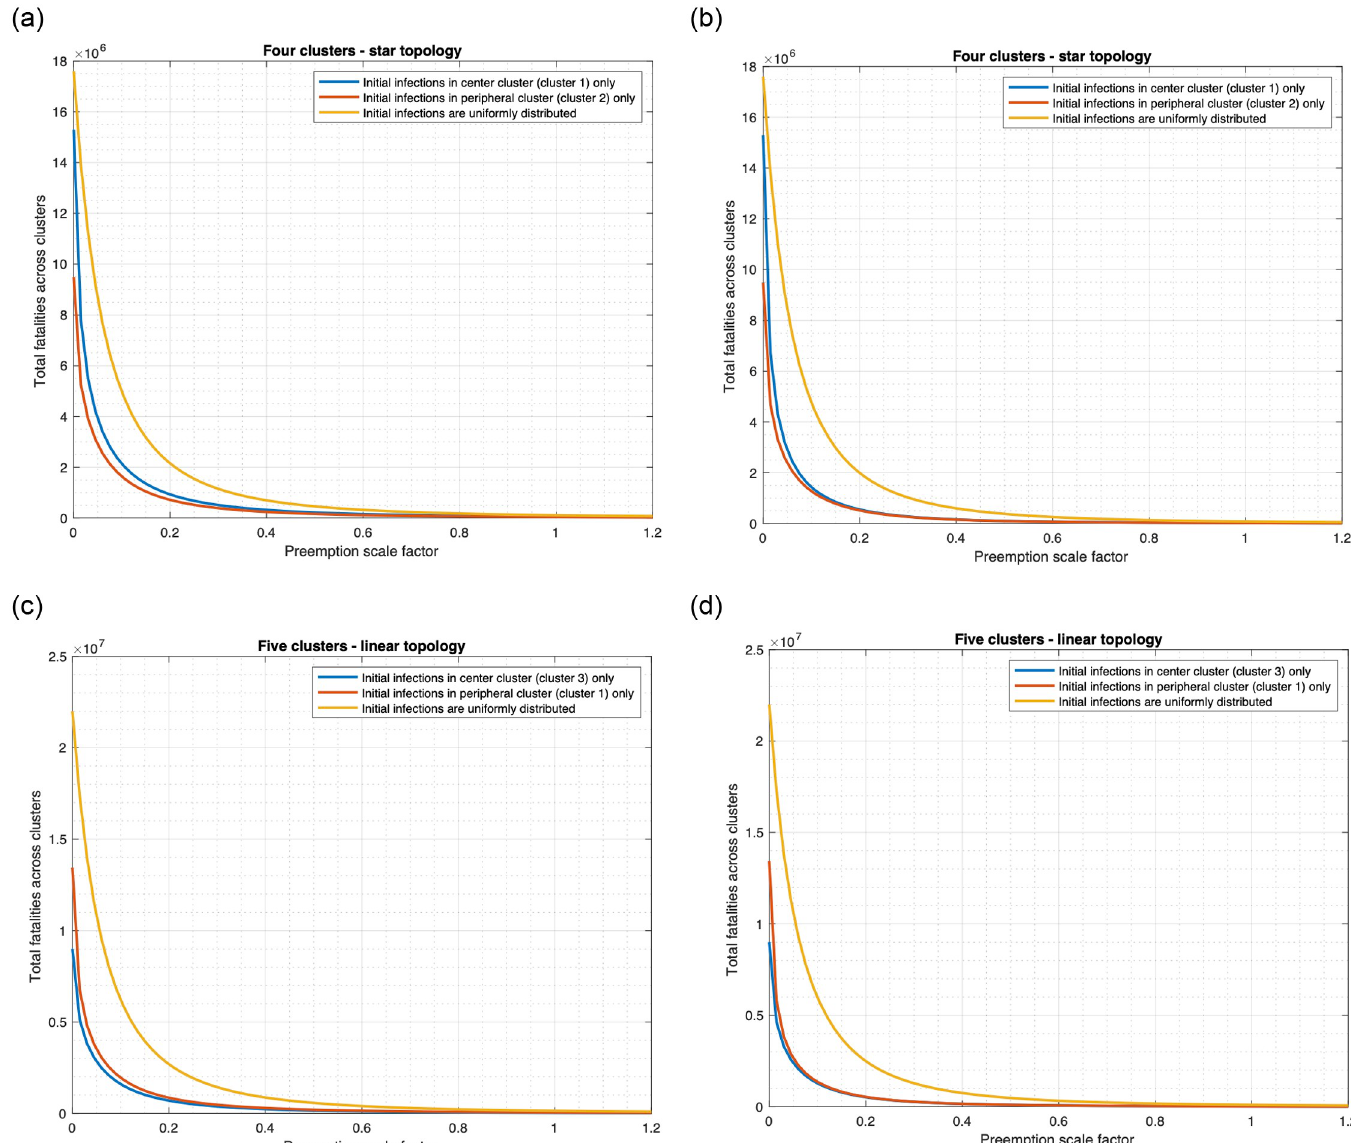
Fig 10. Relationship between fatality and preemption scale factor. (a) Star topology, α = 0.001. (b) Star topology, α = 0.8. (c) Linear topology, α = 0.001. (d) Linear topology, α =